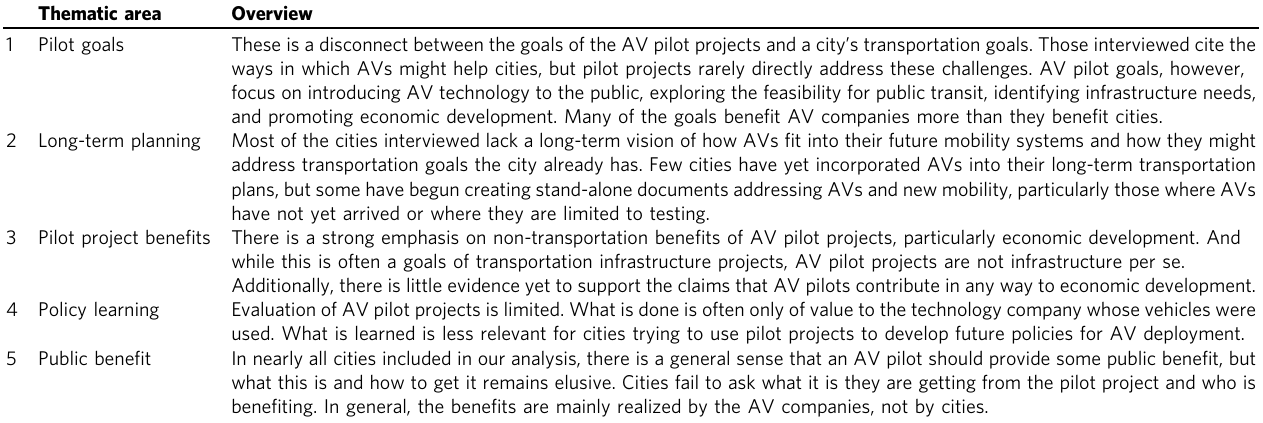
Table 3 Overview of key research fi